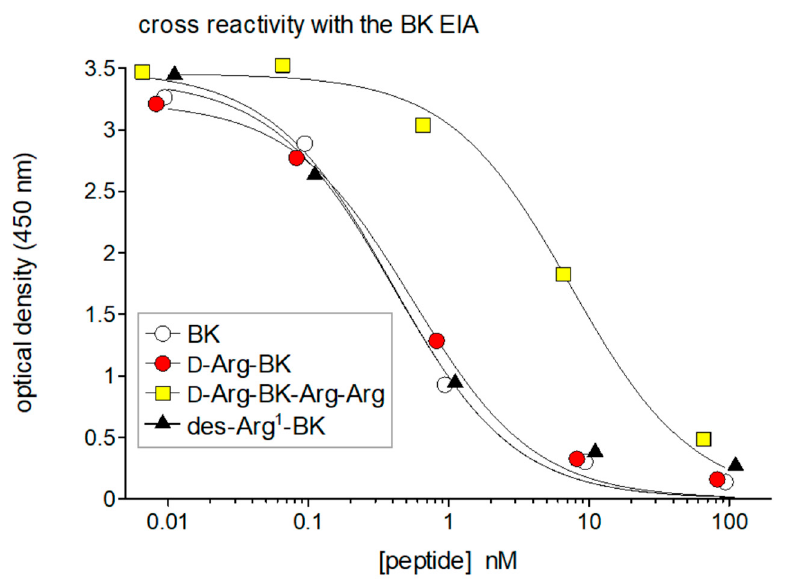
Figure 2. Cross-reactivity of the BK EIA with selected kinin sequences. The inactive metabolite des-Arg 1 -BK ( = BK fragment 2–9) exhibits full cross-reactivity vs. BK. N-terminal extended sequences, like Arg-BK (shown here), or Lys-BK are also fully reactive. Truncated sequences at the C-terminus, like the optimal B 1 receptor agonist Lys-des-Arg 9 -BK, do not cross react at all [12]. An extended sequence like Arg-BK-Arg-Arg, an inactive prodrug releasing active kinins via the action of carboxypeptidases [31], has a partial reactivity, showing the importance of a free COOH terminus. Reproduced in part from [12].